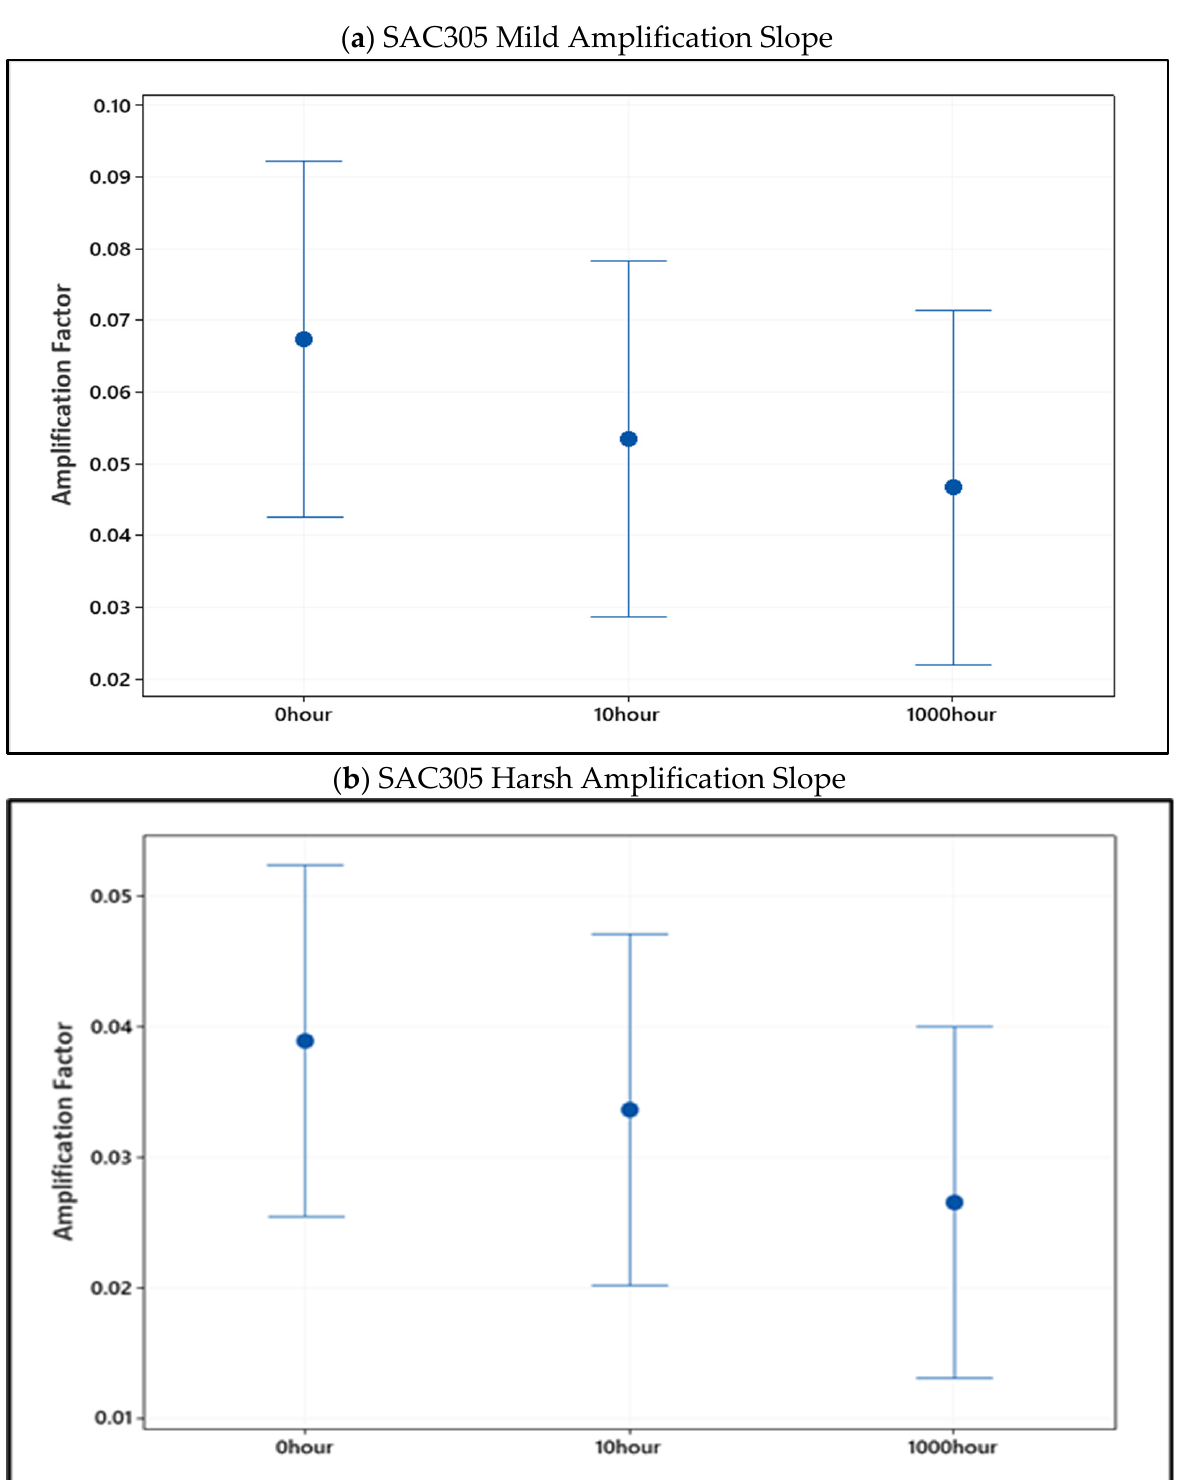
Figure 12. Confidence interval of ( a ) mild and ( b ) harsh amplification slope of non-aged, 10, and 1000 h aged SAC305 individual solder joint.